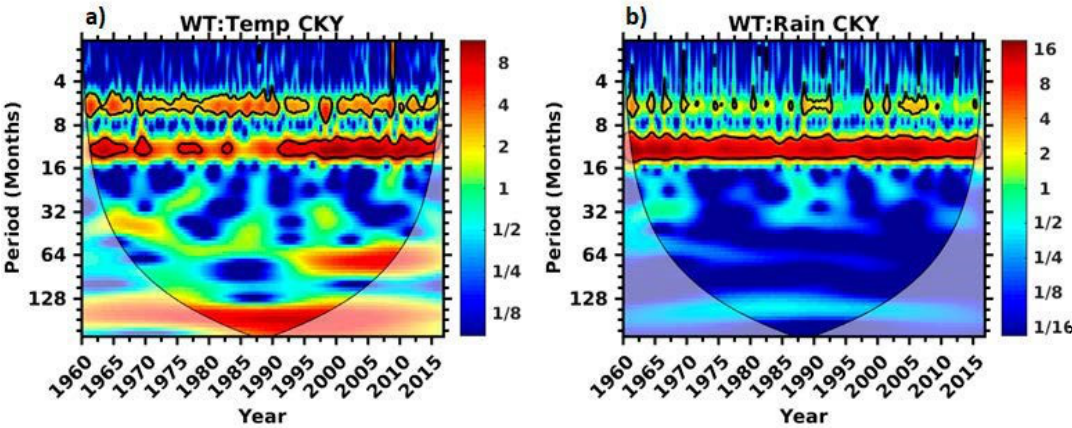
Figure 11. Wavelet transform of temperature ( a ) and rainfall ( b ) variability from 1960 to 2016 at Conakry. The black solid line contour delimits the region (red) where the power is strong and significant and the cone of influence indicates the 95% confidence level.